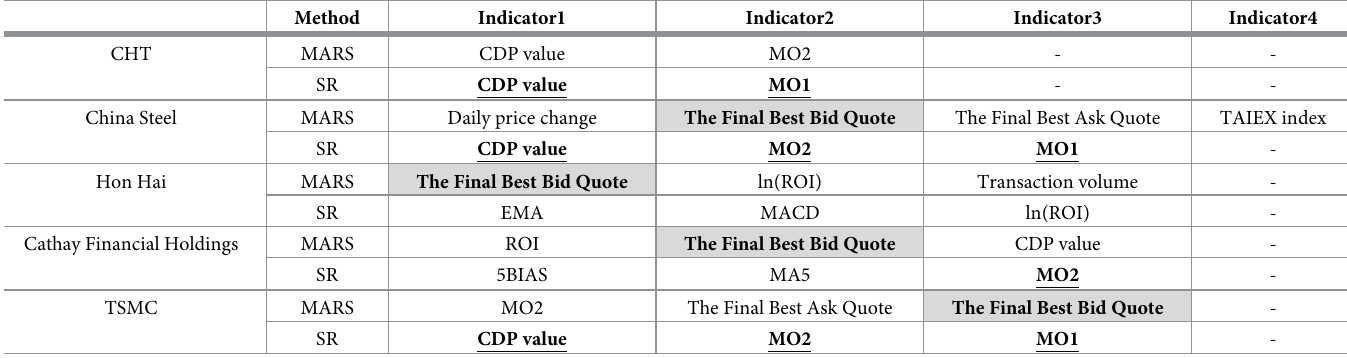
Table 18. The selected features for all